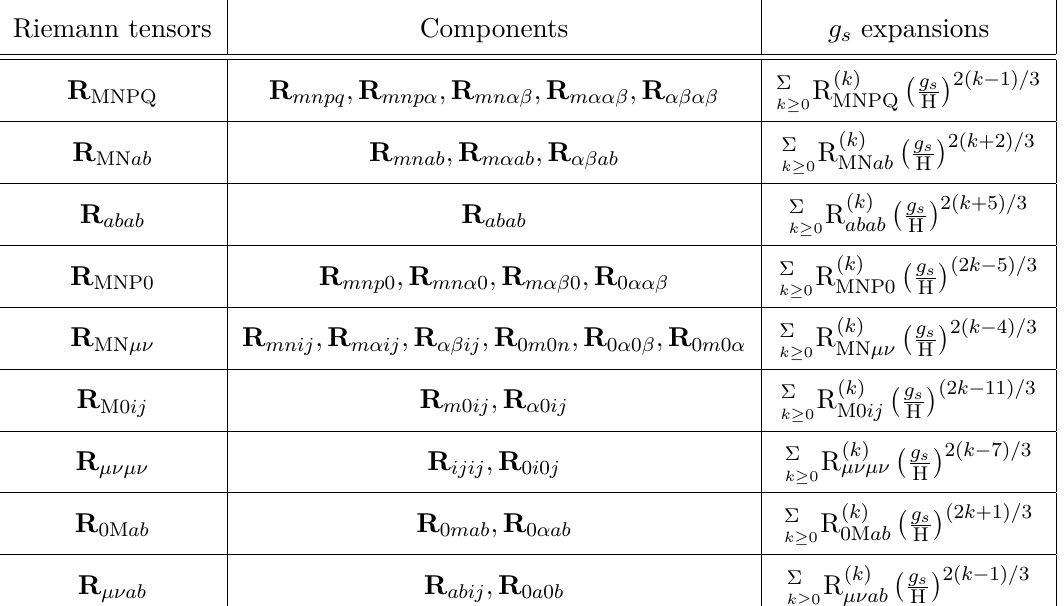
= R ( k ) ( y ) N 1 N 2 N 3 N 4 N 1 N 2 N 3 N 4